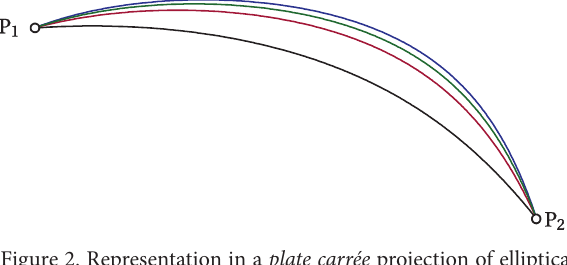
Figure 2. Representation in a plate carrée projection of elliptical sections with coordinate points 1 = f 60°, 1 = λ 0° and 2 = f 30°, = λ 80°. From bottom to top: great ellipse, second normal 2 section, mean normal section and first normal section. The ellipsoid flattening was exaggerated at =1/2